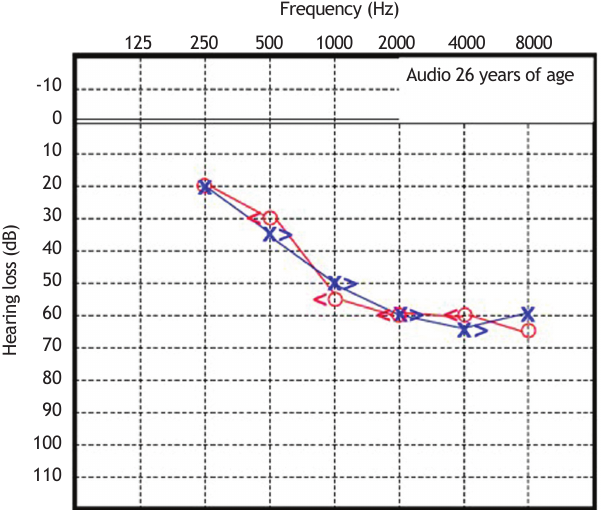
Figure 5 Audiometry in patient 2, performed at 11 years of